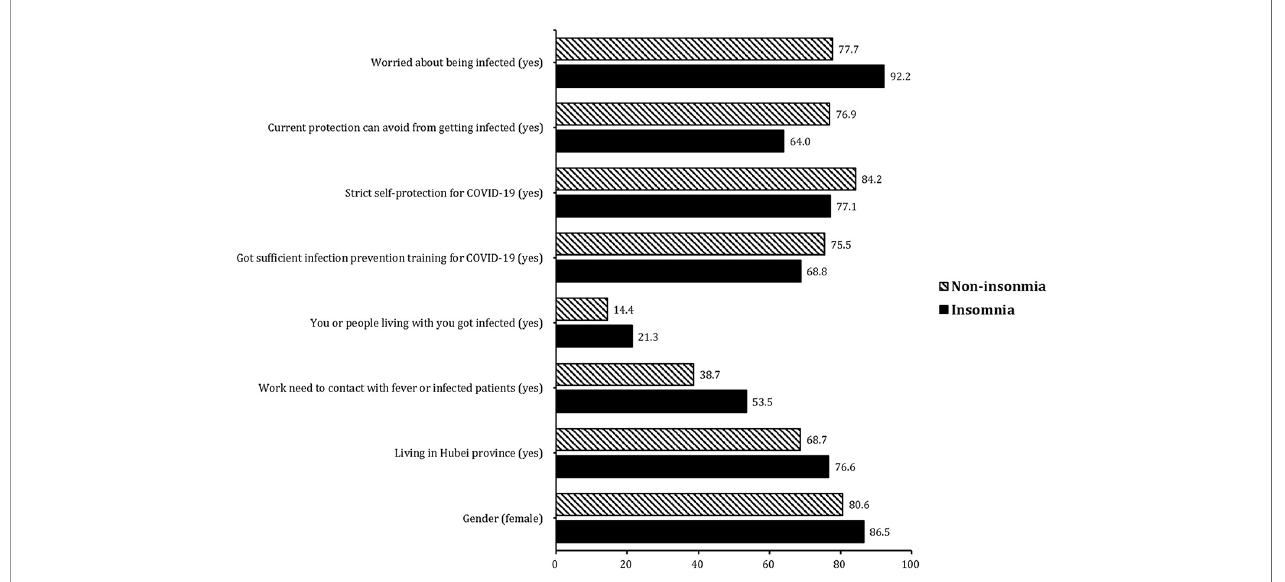
FIGURE 1 | Signi fi cant differences between the insomnia group and non-insomnia group in demographic data and sociopsychological factors.